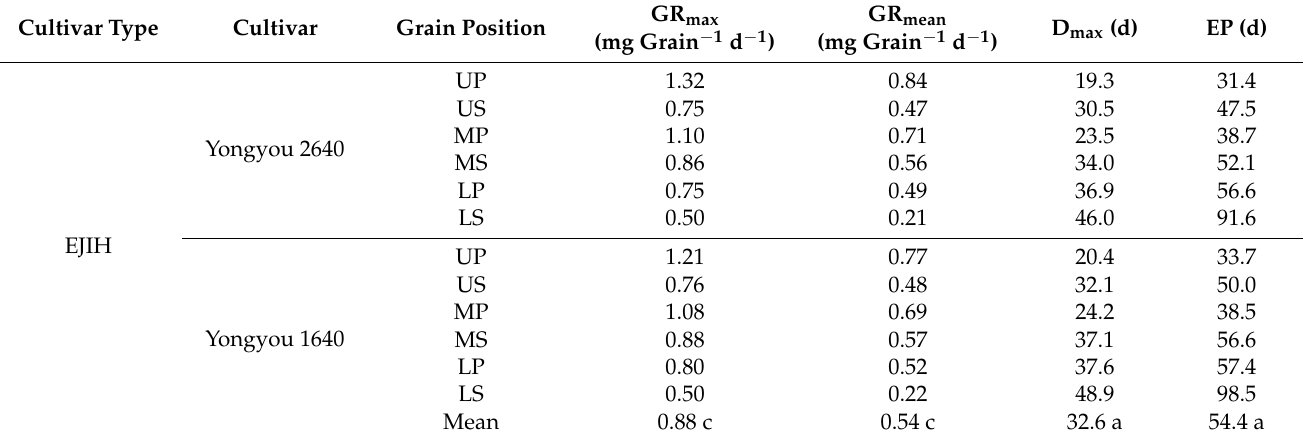
Table 9. Some parameters of the grain-filling process of rice